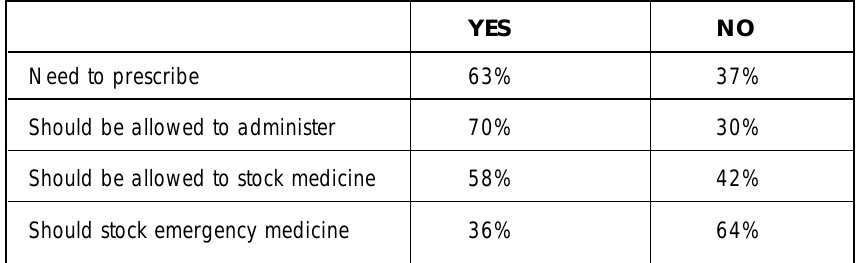
Table 1: Need to prescribe, administer and stock medicines.